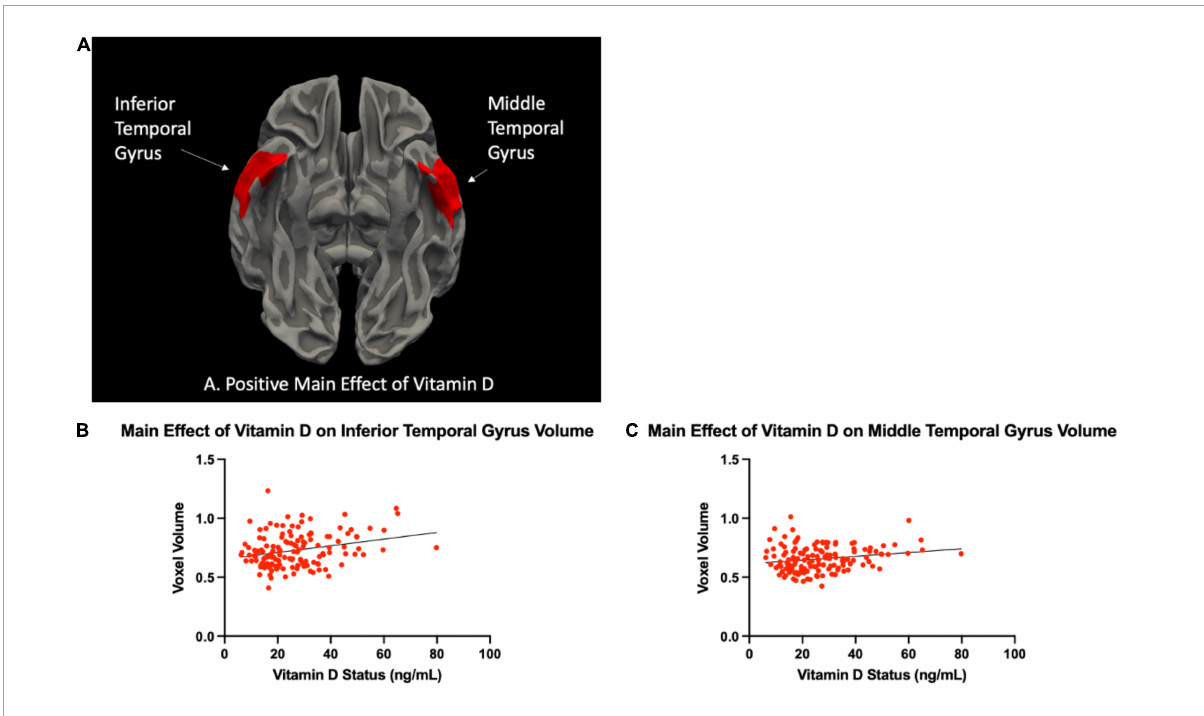
FIGURE3 (A) The area of two cortical clusters overlapping with the left inferior and right middle temporal gyri {regions of the Destrieux atlas [FreeSurfer aparc.a2009s (Destrieux et al., 2010)] containing the maximum T-statistics} was higher for individuals with higher Vitamin D status. To ease visual interpretation, we have used red to represent the significant positive Vitamin D status-area correlation. Scatter plots of the cortical area in the cortical vertices where the T-statistics of these regressions were maximum, versus each Vitamin D status, are shown in panels (B,C)